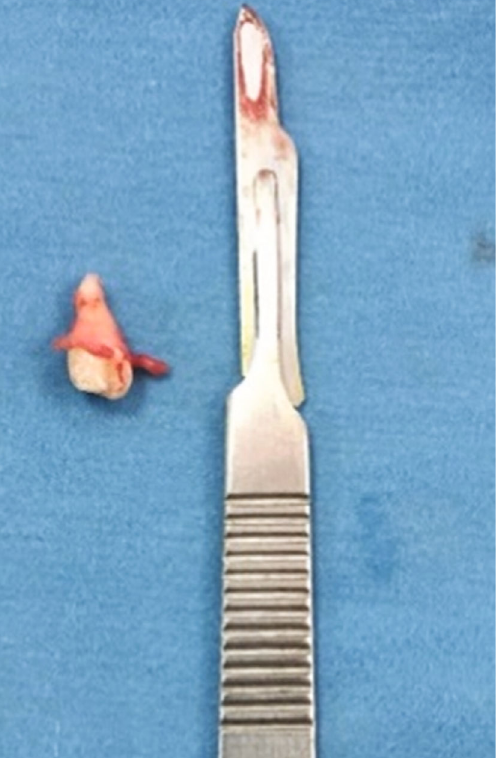
Figure 5: Extracted ectopic premolar tooth and attachment of cyst lining.